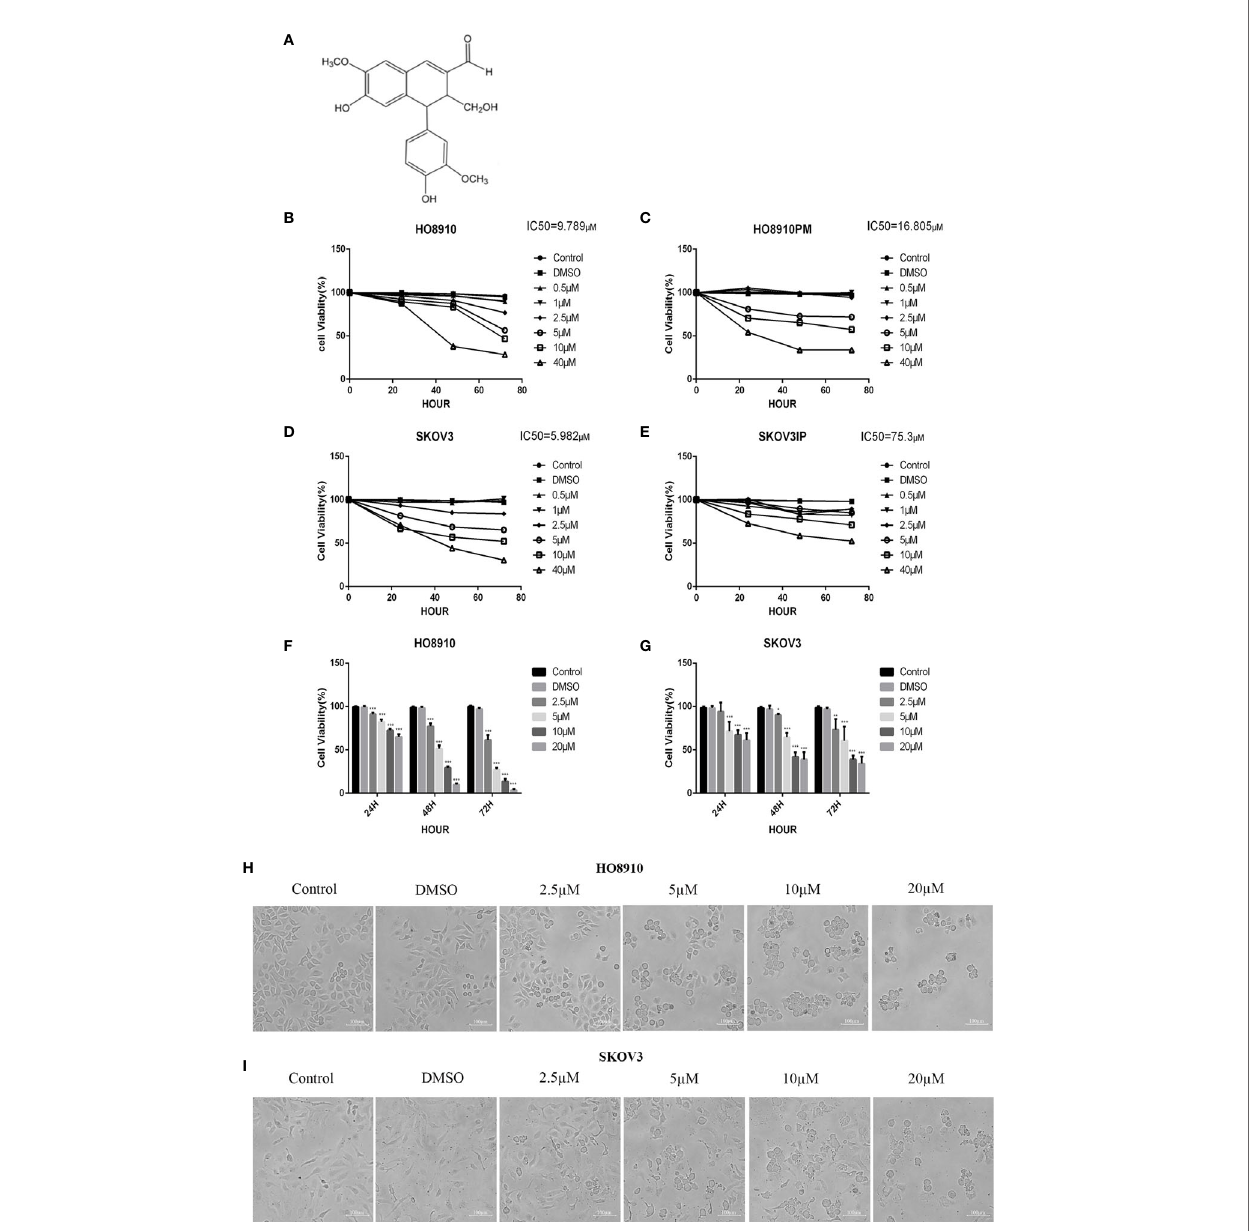
FIGURE 1 | VB1 suppressed the viability of human ovarian cancer cells. (A) Chemical structure of VB1. (B – E) The four cell lines were treated with VB1 for various times and dosages, respectively, and the cell viability was tested by CCK-8. (F) HO8910 cells were treated with VB1 (0 µM) (control), 0.1% DMSO, and VB1 (2.5 – 20 µM) for 24, 48, and 72 h, and the cell viability was measured using CCK-8 assay. (G) SKOV3 cells were treated with VB1 (0 µM), 0.1% DMSO, and VB1 (2.5 – 20 µM) for 24, 48, and 72 h; the cell viability was measured using CCK-8 assay. (H) The cell morphologic changes of HO8910 cells after treatment with VB1 (0 µM), 0.1% DMSO, and VB1 (2.5 – 20 µM) for 24 h (magni fi cation ×100). (I) The cell morphological changes after treatment with VB1 (0 µM), 0.1% DMSO, and VB1 (2.5 – 20 µM) for 24 h in SKOV3 cells (magni fi cation ×100). The data represent the mean ± SD of three independent experiments, *P < 0.05, ***P < 0.001 compared with